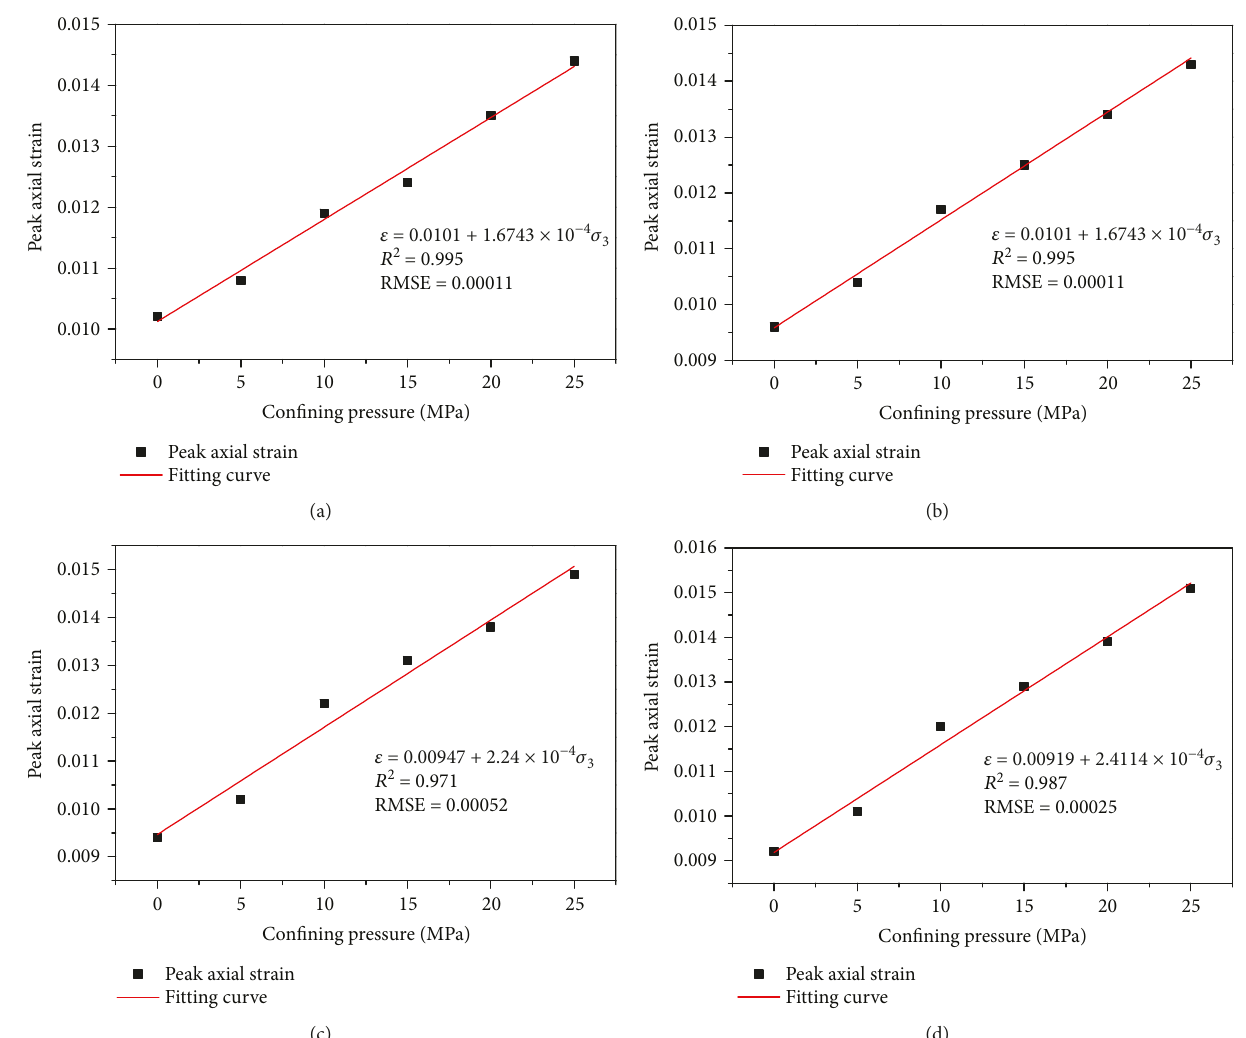
Figure 2: Peak axial strain at various con fi ning pressures of sandstone specimens treated with di ff erent chemical corrosions. The chemical environment is (a) H SO solution, (b) NaOH solution, (c) distilled water, and (d) natural 2 4